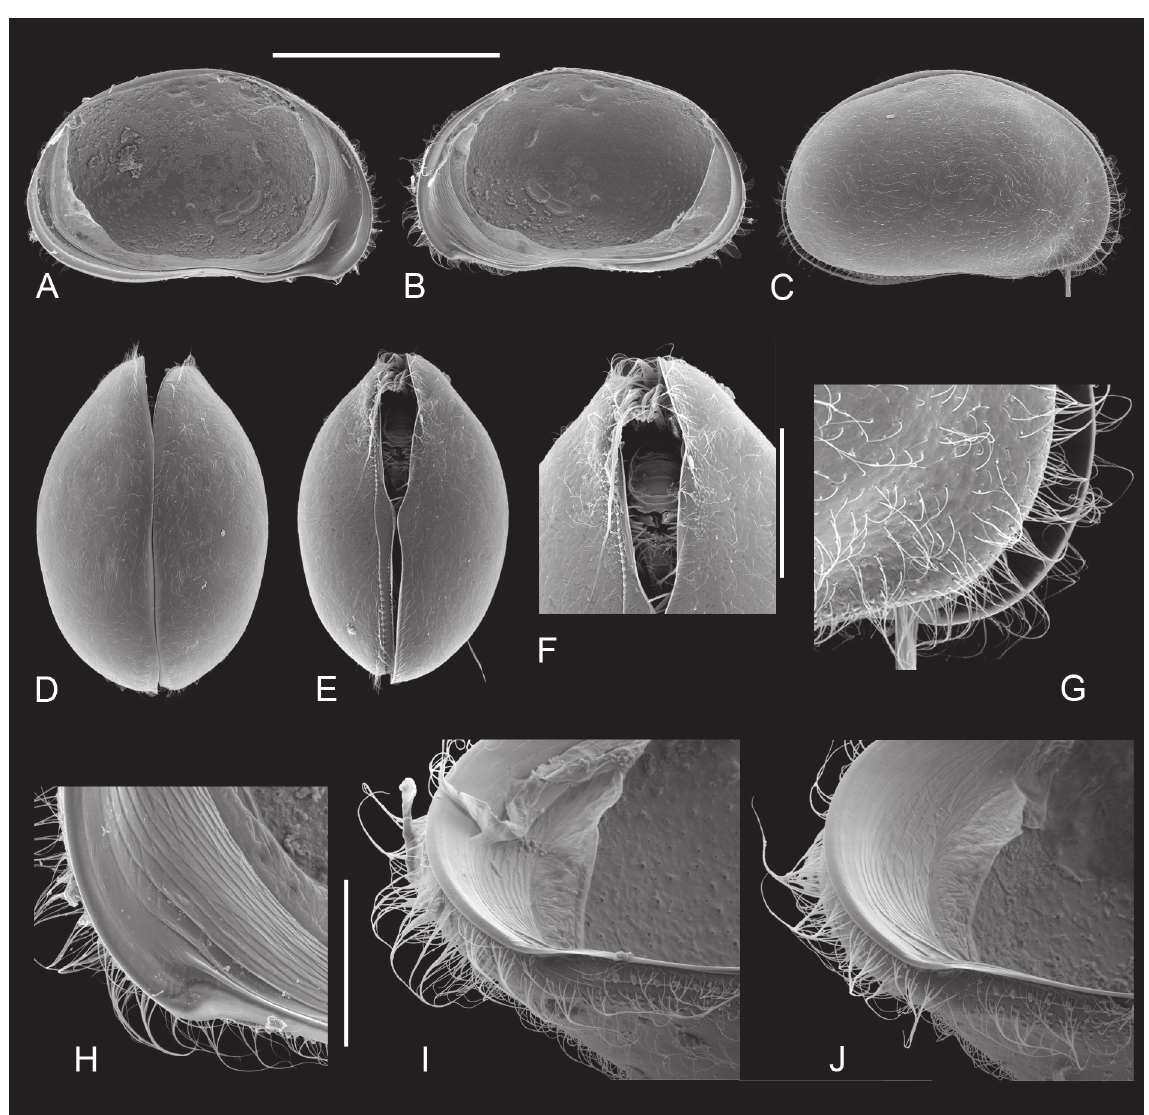
Fig. 15. Bennelongia ivanae sp. nov., type specimens from type locality (Holland rocks, DJc/02). A . ♀ holotype, LVi (WAMC52280). B . ♀ holotype, RVi (idem). C . ♀ paratype, CpRL (OC.3327). D . ♀ paratype CpD (WAMC52281). E . ♀ paratype, CpV (WAMC52282). F . ♀ paratype, CpV, detail anterior (idem). G . ♀ paratype, CpRL, detail anterior (OC.3327). H . ♀ holotype, RVi, detail anterior (WaMc52280). I . ♀ holotype, RVi, detail anterior, tilted (idem). J . ♀ paratype, RVi, detail anterior, tilted (Oc.3326). scales: a-e = 1 mm; F = 400 µm; G-J = 200